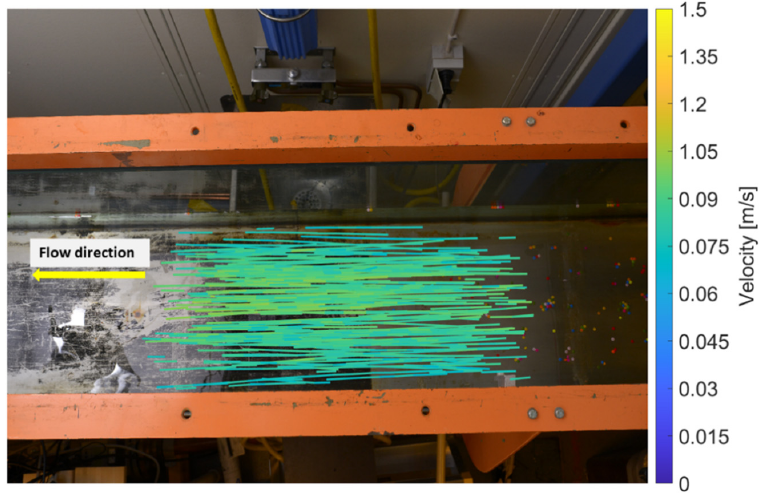
Figure 4. Surface flow velocity field of the laboratory flume measurement.